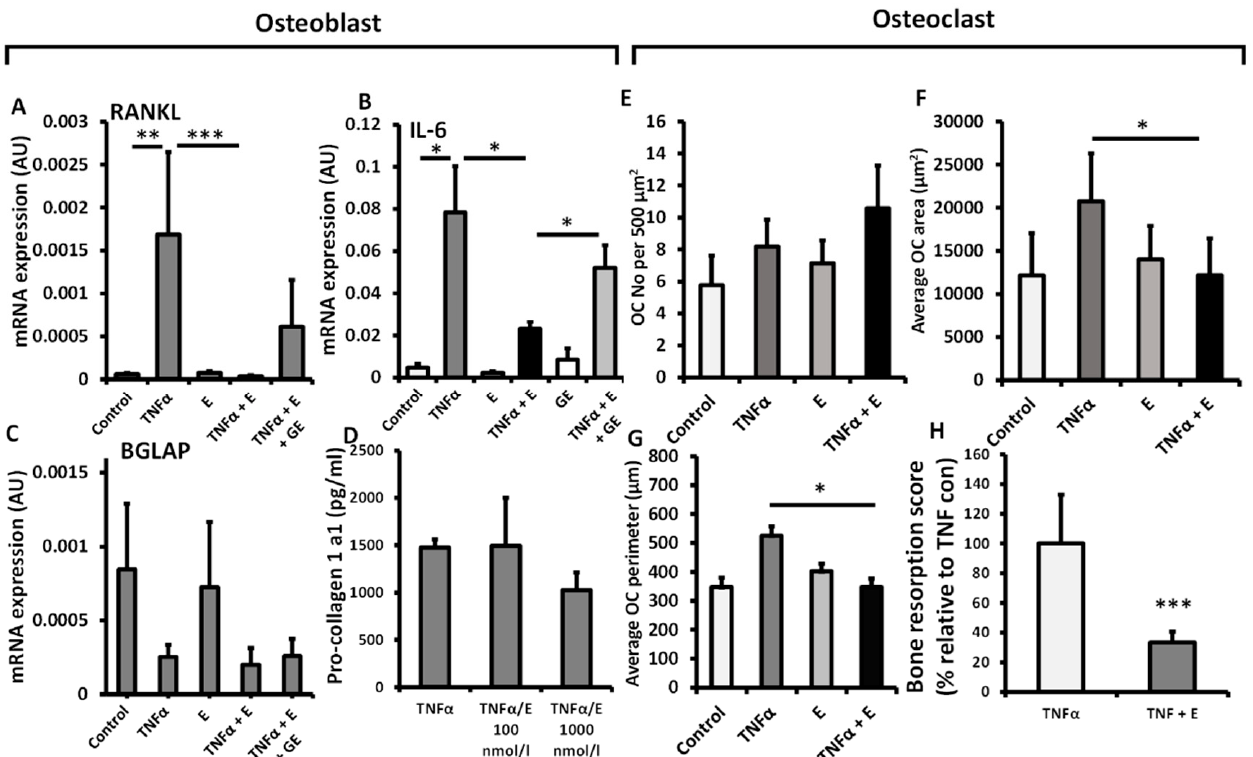
Figure 2. mRNA e xpression (AU) of ( A ) TNFSF11, ( B ) IL6 and ( C ) BGLAP determined by RT qPCR in primary human osteoblast culture isolated from OA tibia, following treatment with either TNF α (10 ng/mL), cortisone (denoted E) (1000 nmol/L), glycyrrhetinic acid (GE) (1 μ M) or a combination